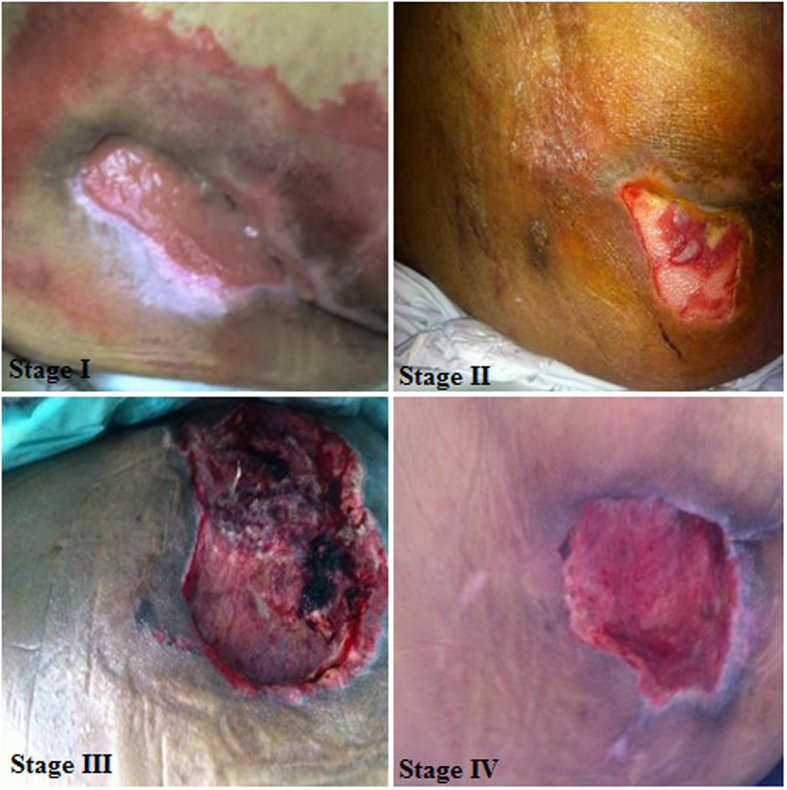
Stages of pressure ulcer.